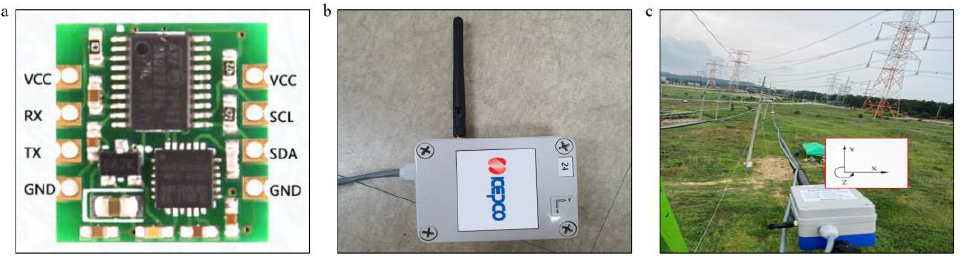
Figure 2. ( a ) WT61 module. ( b ) Utilized acceleration sensor in KEPCO. ( c ) Example of installed ac- celeration sensor in KEPCO.